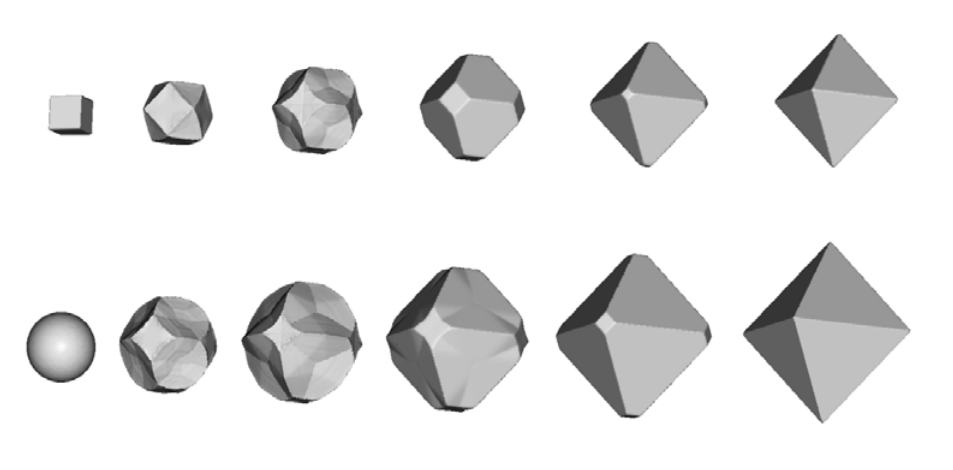
Figure 7. Artificial growth of the cube (upper row) and the sphere (lower row) with the growth rates given by the thirteen-parameters etching rate interpolation formulas for 30% etchant